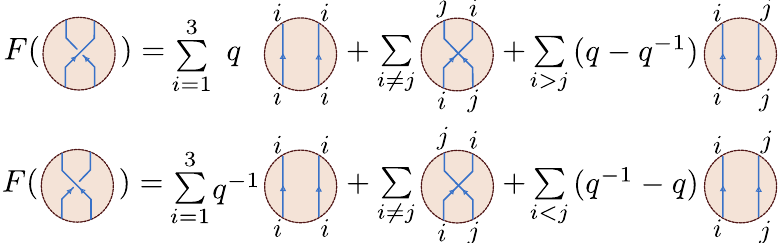
Figure 28 . Top: the result of applying F to the indicated overcrossing. The right side represents a formal linear combination of open paths on f M . The first two terms come from the simple lifts of the link; in the first term we have resolved using the gl (1) skein relations. The last term involves contributions from the cluster of exchanges localized near the crossing. Bottom: the result of applying F to the indicated